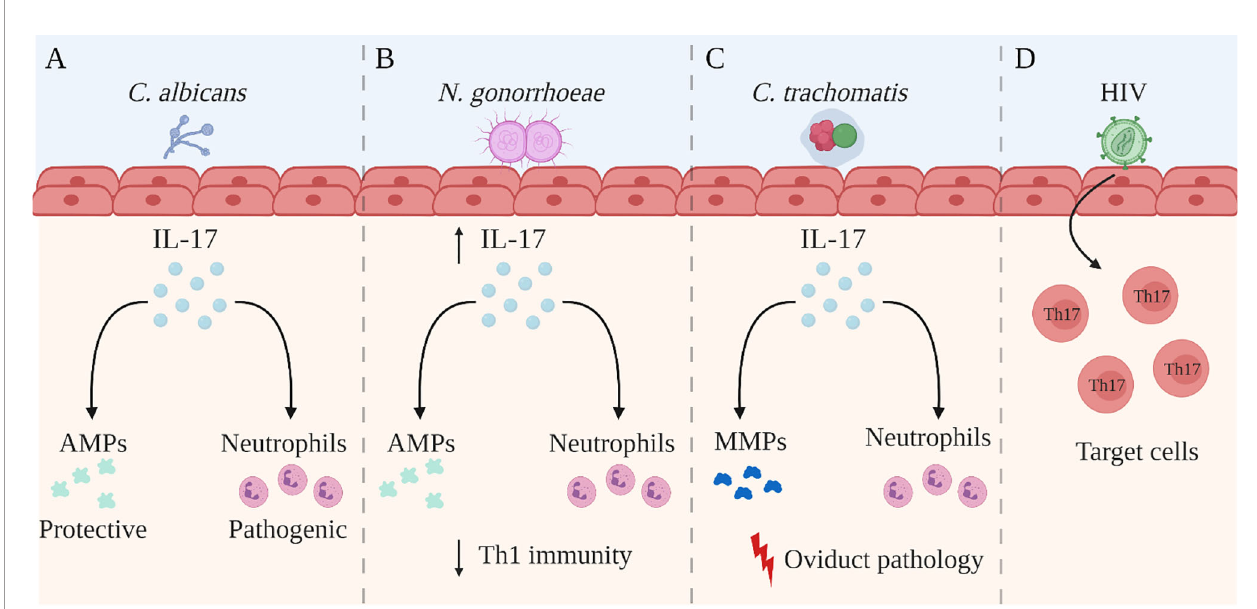
FIGURE 2 | Summary of the role of IL-17 in the female reproductive tract. The role of IL-17A (IL-17) in the female reproductive tract (FRT) is disease-speci fi c and is not yet completely understood. Studies have reported the following regarding the role of IL-17 during genital infection with Candida albicans ( C. albicans ), Neisseria gonorrhoea ( N. gonorrhoeae ), Chlamydia trachomatis ( C. trachomatis ), and human immunode fi ciency virus (A) IL-17 is involved in recruiting neutrophils and inducing the production of anti- microbial peptides (AMPs) during C albicans infection. While AMPs have shown to be protective against C albicans infection in the FRT, neutrophils may be causing more damage than protection. (B) N. gonorrhoeae infection in the FRT selectively induces a robust Th17 response but reduced protective Th1 immunity, allowing evasion of host mechanisms of protection. However, the elevated IL-17 production has been shown to be important for controlling early gonococcal infection, as well as for recruiting AMPs and neutrophils. (C) During C trachomatis infection in the FRT, the recruitment of neutrophils and the production of matrix metalloproteases (MMPs) by IL-17 has been associated with greater oviduct pathology. (D) HIV preferentially infects activated Th17 cells which express CD4 and high levels of HIV co-receptors. Created with